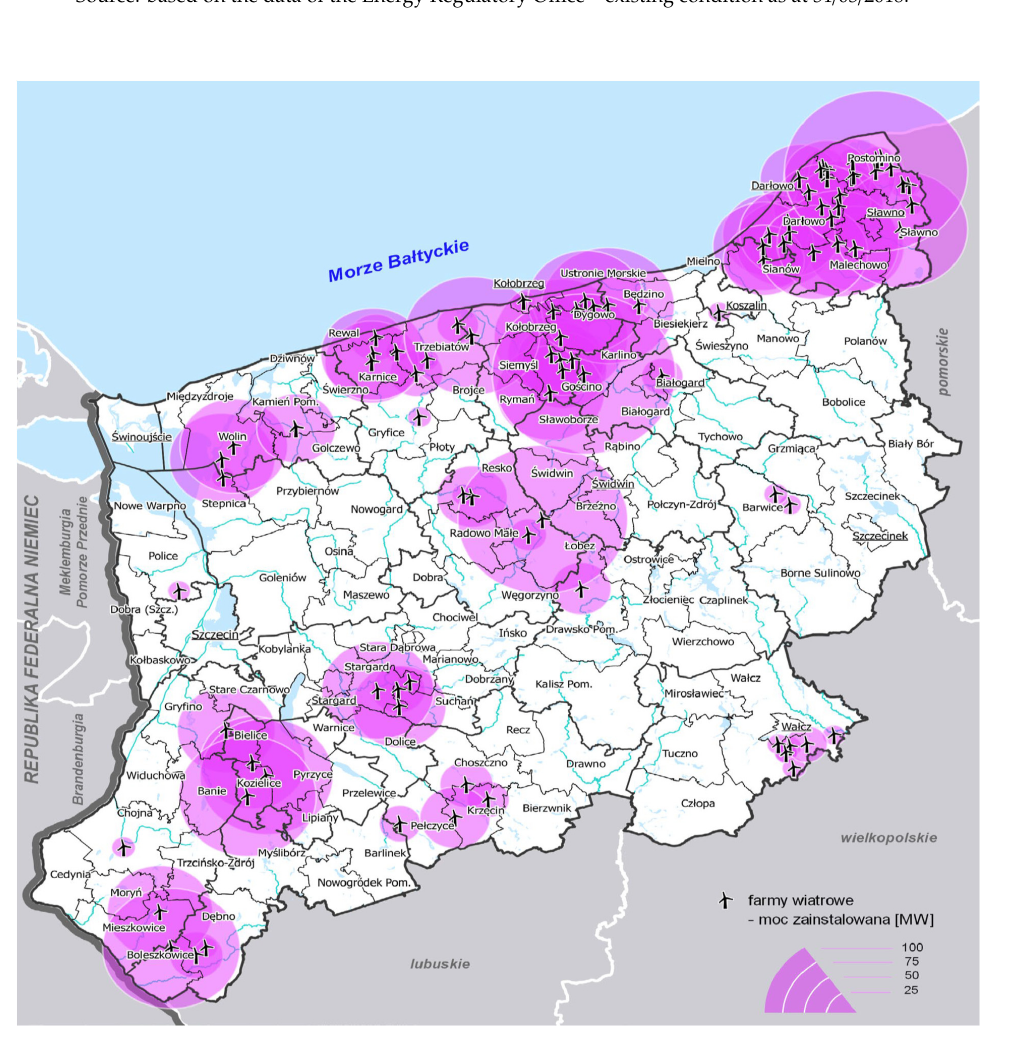
Figure 1. Location of wind farms in the West Pomeranian Region. (Source: Based on data from the Regional Bureau of Spatial Management of the West Pomeranian Region, as of 31/03/2018.)